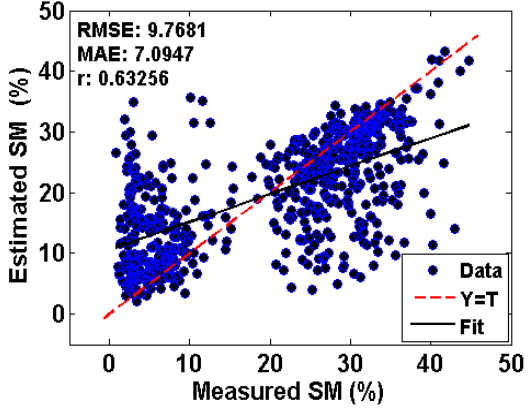
Figure 15. The relationship between measured and estimated SM for combined Datasets 1&3.